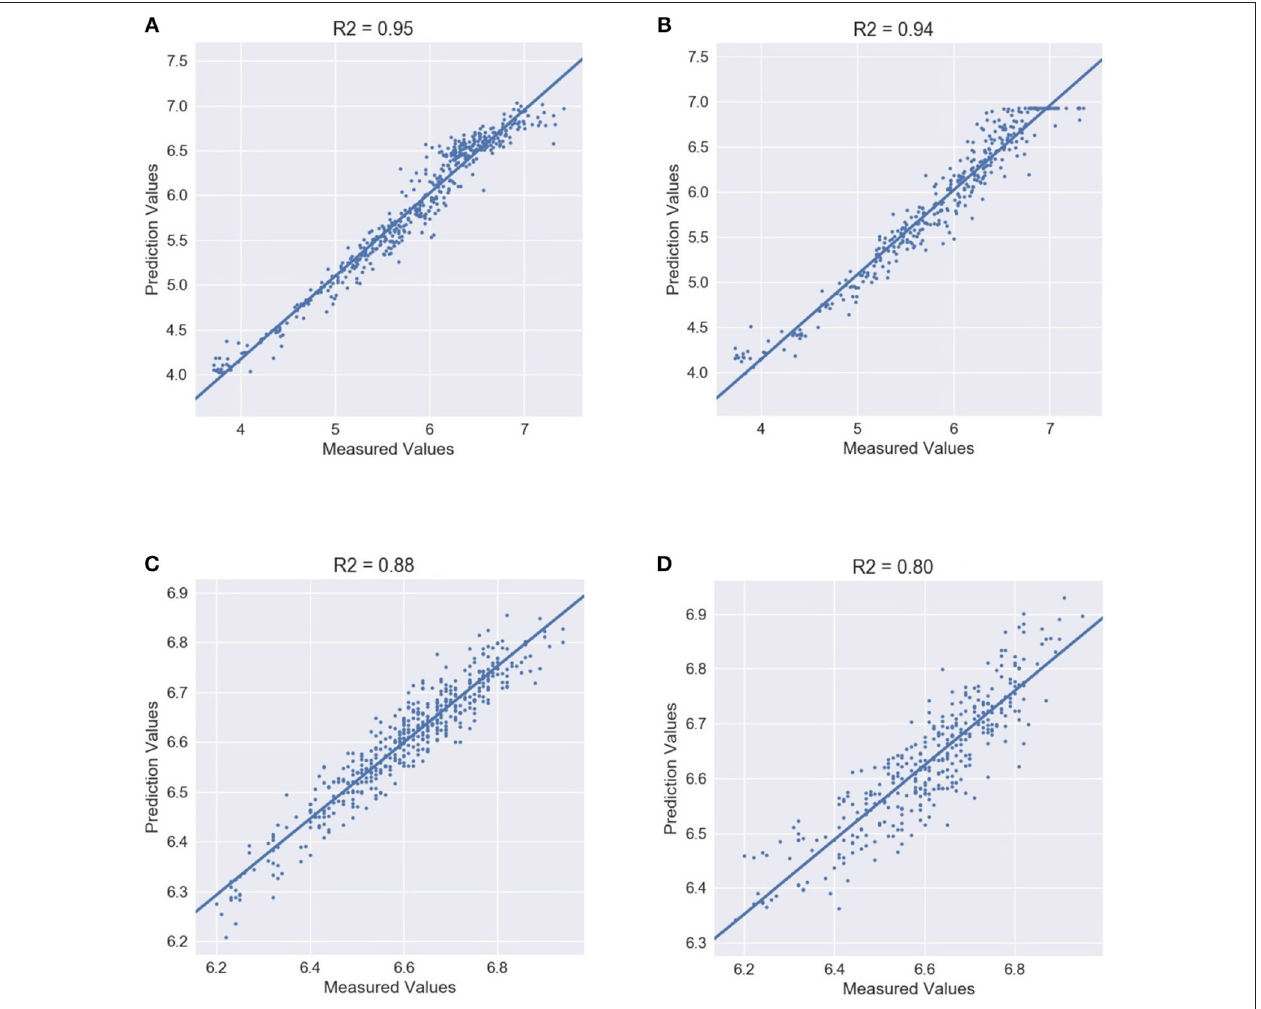
FIGURE 8 | 90/120 min ahead prediction and measured value comparison. Wet-90 represents the experimental case for 90 min ahead prediction for the wet season. Other cases are named in the same way. (A) Wet-90 DO prediction. (B) Wet-120 DO prediction. (C) Dry-90 DO prediction. (D) Dry-120 DO prediction.